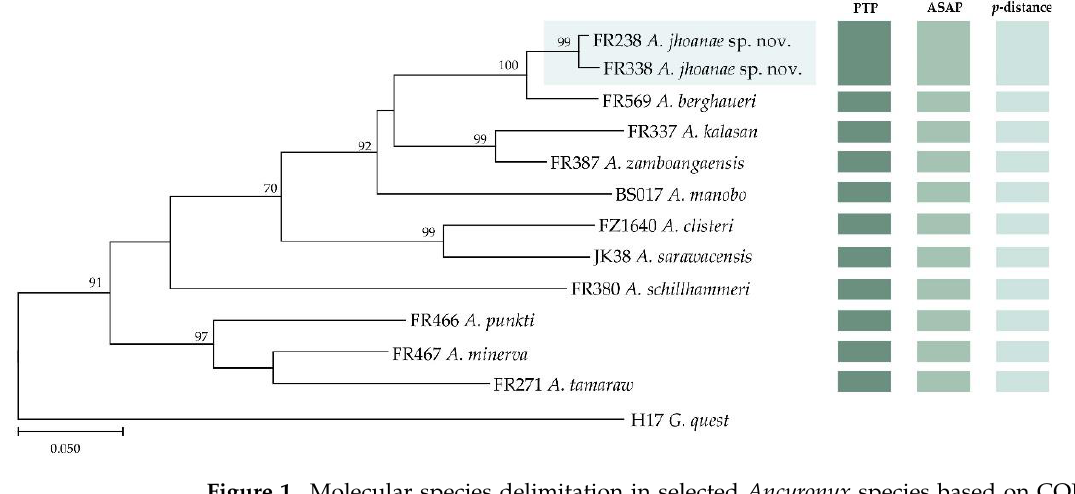
Figure 1. Molecular species delimitation in selected Ancyronyx species based on COI alignment (662 bp) with putative species clusters determined through Poisson Tree Processes (PTP), Assemble Species by Automatic Partitioning (ASAP), and p -distance ( p ). Maximum likelihood (ML) tree shows topology based on general time-reversible (GTR + G + I) model, 1000 bootstraps. Bootstrap values below 70 are not shown. Table 2. Uncorrected p -distance (in %) of Ancyronyx species based on COI alignment (662